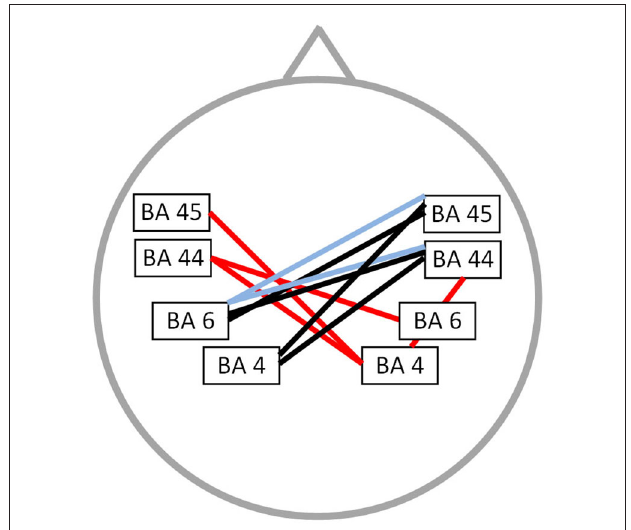
FIGURE 3 | Correlation between neural connectivity and TSS-R . Positive correlation between neural connectivity and stuttering severity ( p < 0.05) for the theta frequency band (orange lines) and the alpha 2 frequency band (green line).